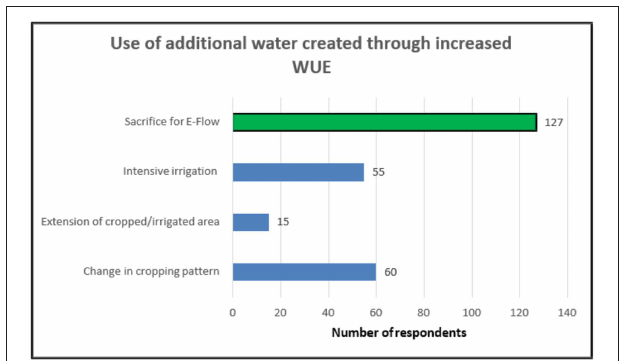
FIGURE 3 | Preference of farmers to use saved water through WUE initiatives in